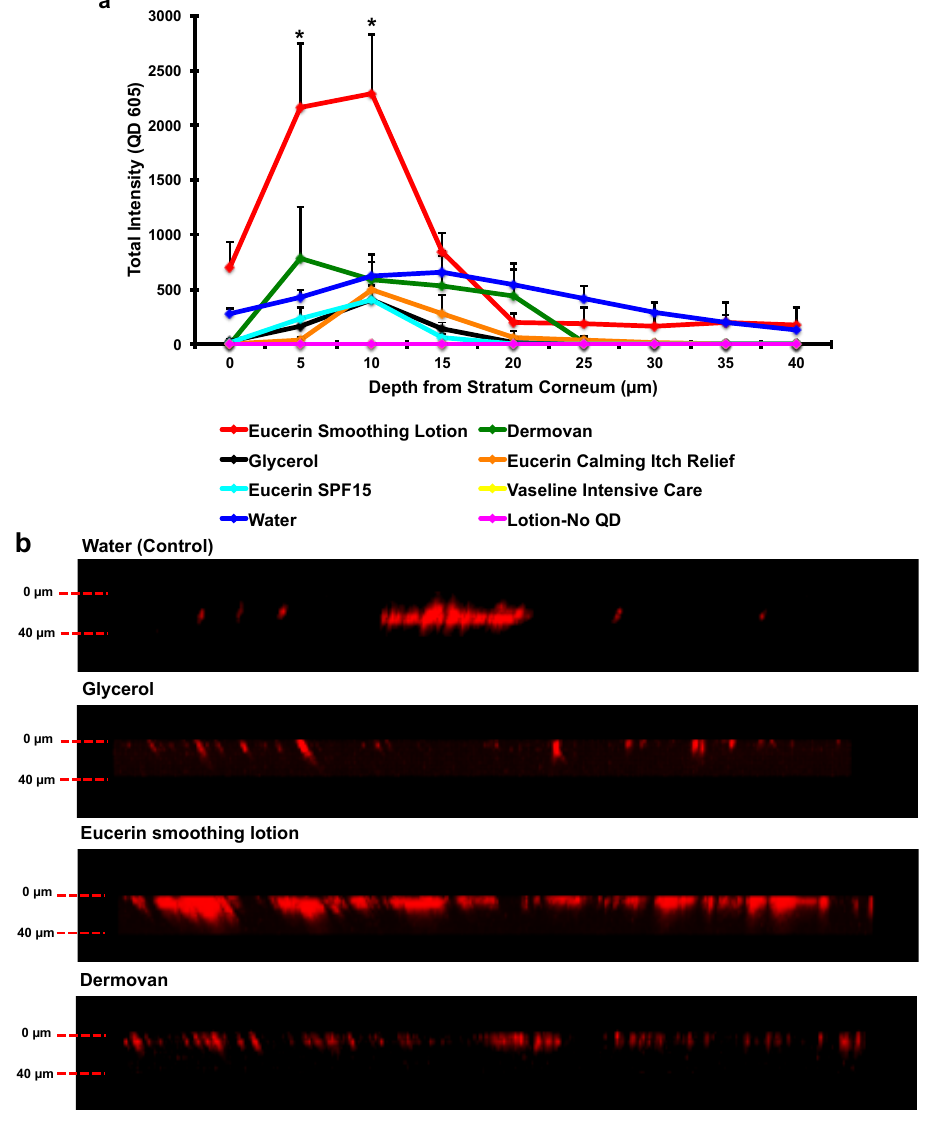
Figure 2. Eucerin Smoothing lotion enhances QD penetration through ex vivo mouse skin in the petri-dish protocol. ( a ) Significant increase in the QD presence was observed in the Eucerin smoothing lotion group at depths of 5 and 10 µm from the stratum corneum compared to water. All other vehicles exhibited QD penetration trends similar to or lower than the water treated group. Vaseline intensive care lotion exhibited negligible penetration; Mean ± SEM ( N = 4, n = 3); ( b ) three-dimensional reconstruction of the z-stacks (0–40 µm) obtained by using CLSM shows that QDs do not penetrate skin by a uniform Fickian diffusion process. QDs appear to penetrate into the viable epidermis through high fluency entry points in the stratum corneum. * p < 0.05 vs. water.